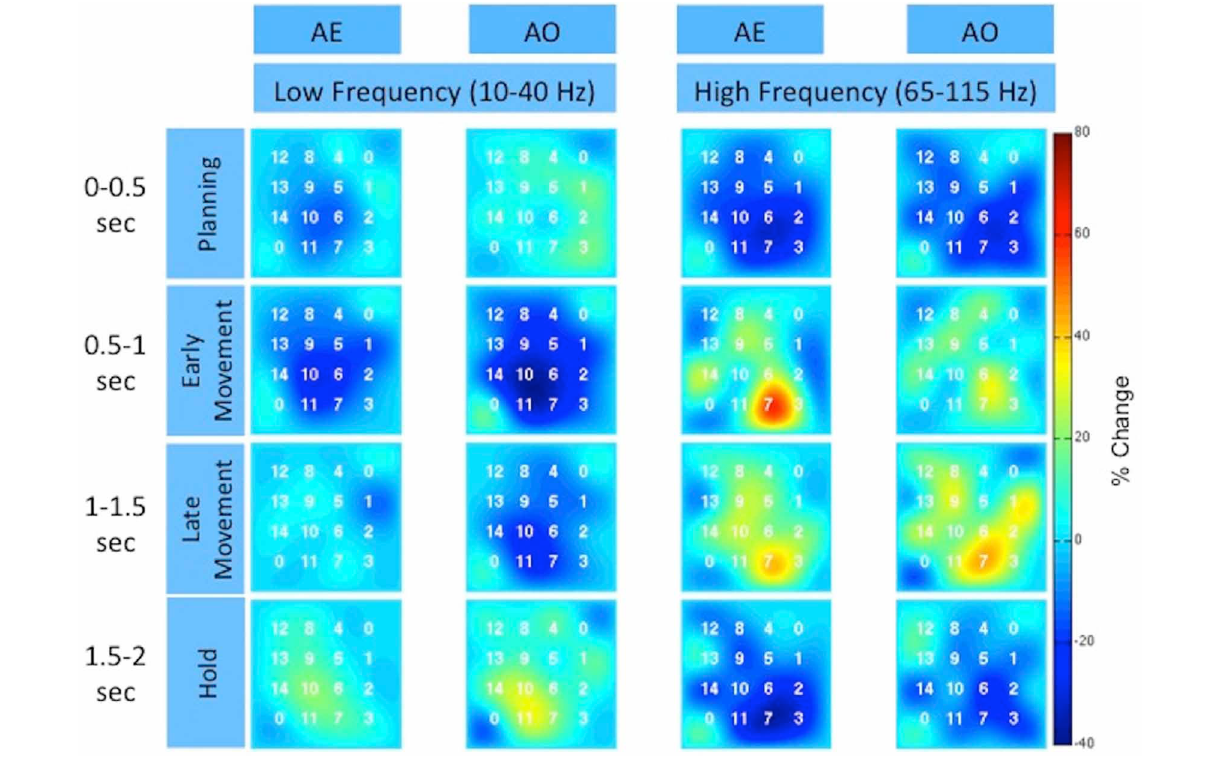
spectral power normalized to the average activity recorded by the electrode over all repetitions. The two corner electrodes marked as “0” served as reference